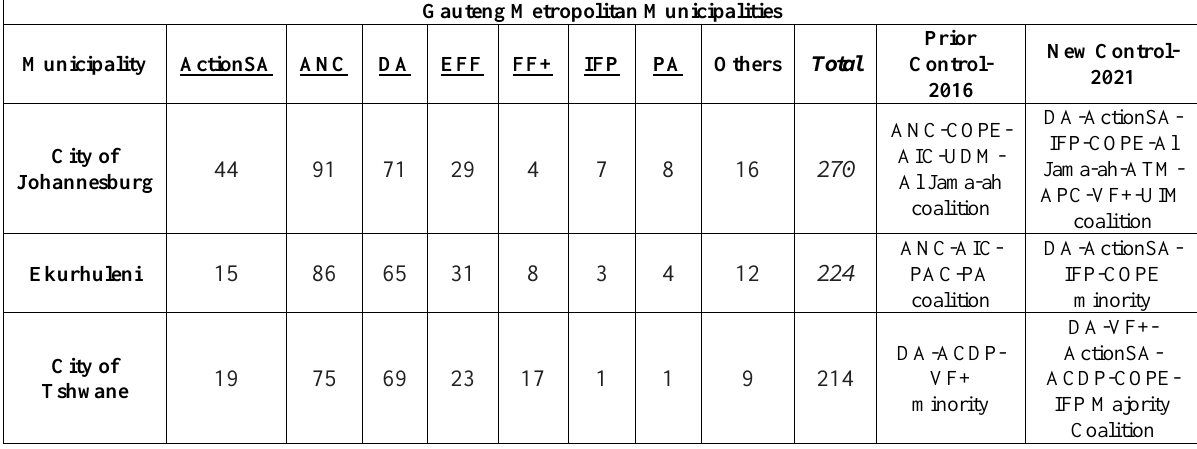
Table 1. Gauteng Metropolitan Local Government Election Results in November